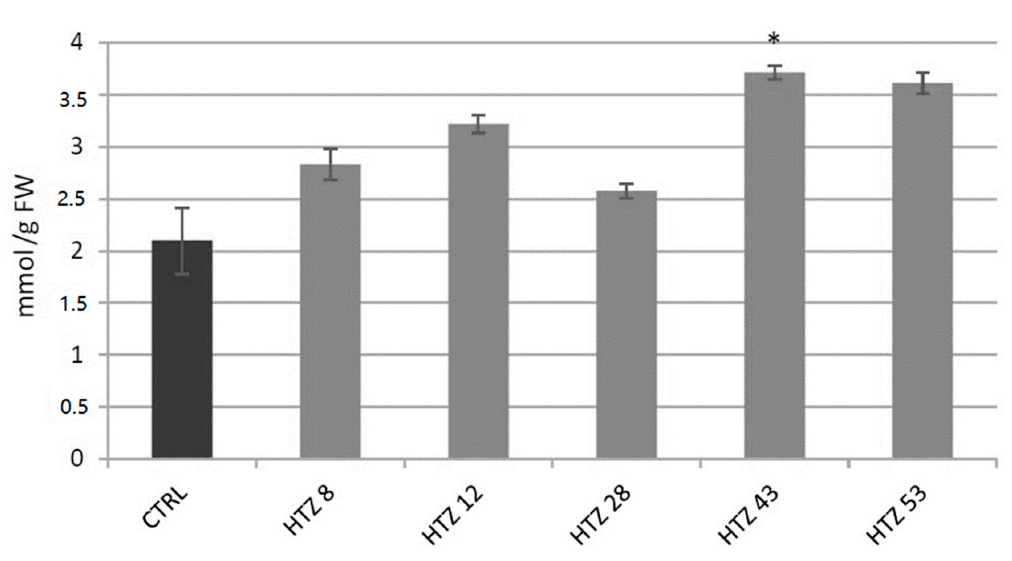
Figure 6. The level of H 2 O 2 in HTZ potato lines compared to the non-transgenic potato (CTRL) presented as the means of six biological replicates ± standard deviation. Statistically significant changes ( p < 0.05) are marked with asterisks.